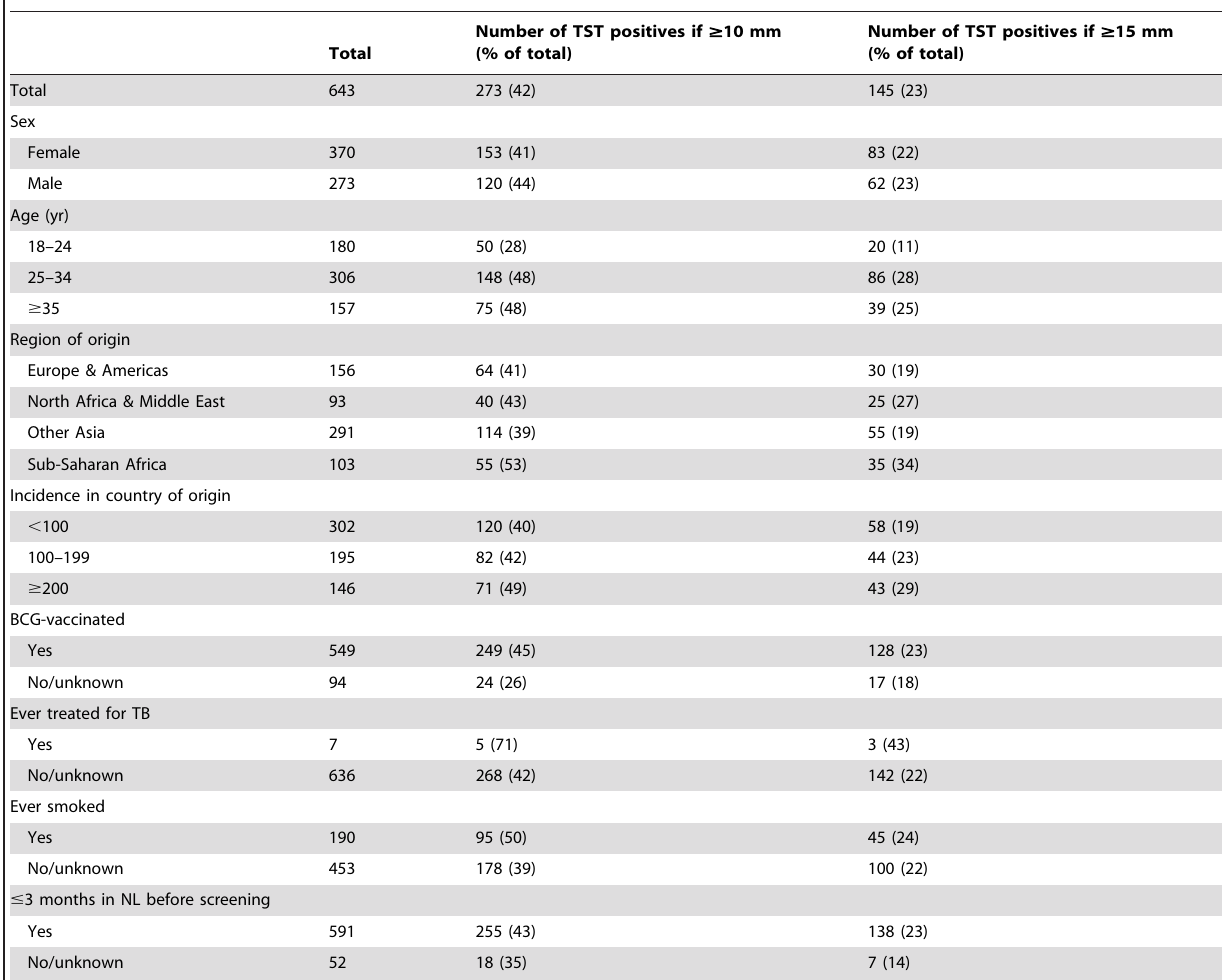
Table 2. Prevalence of TST positives for cut-off value $ 10 mm and $ 15